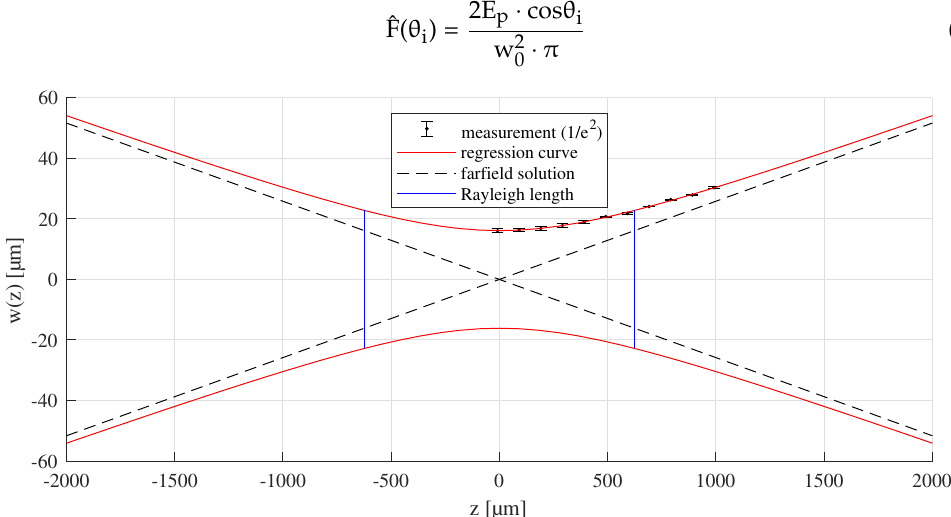
Figure 1. Result of the beam characterisation for a focal length of f = 160 mm revealing a focal radius of w 0 = 16.13 µ m, a Rayleigh length of z R = 624.34 µ m, an opening angle of 1.48° for the farfield solution and an M 2 of 1.27.